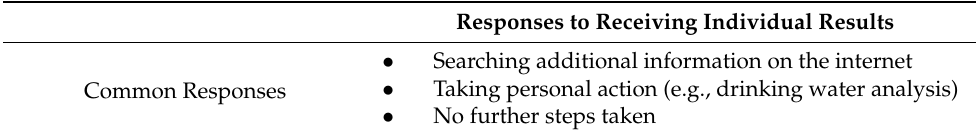
Table 6. Common responses to the topic of study